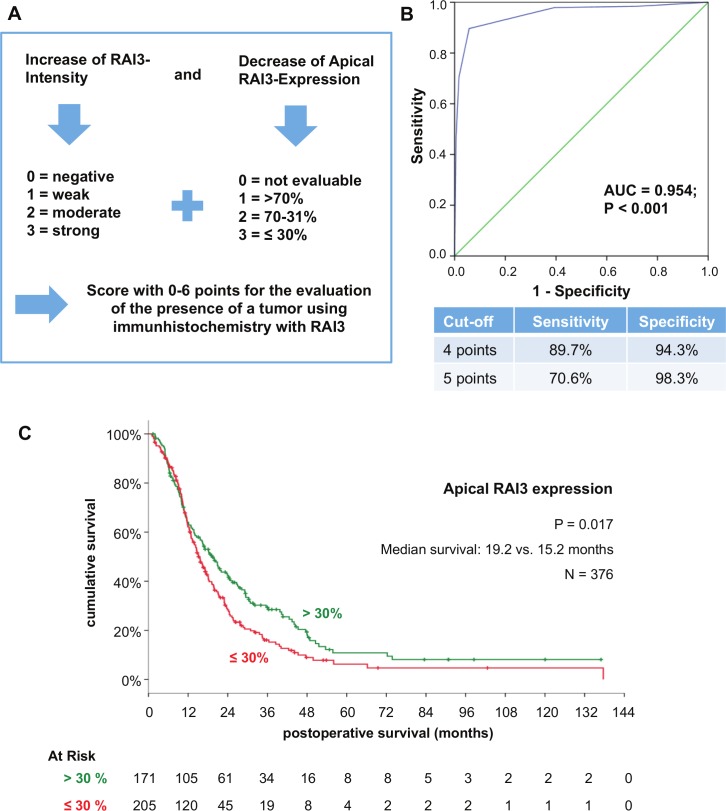
RAI3 immunohistochemistry as diagnostic and prognostic instrument.A: Definition and calculation of a diagnostic score for the presence of a pancreatic ductal adenocarcinoma (PDAC); B: Receiver Operating Characteristic (ROC) curve for the diagnostic score using for distinction of PDAC from Normal or Chronic Pancreatitis (CP) tissue (Sensitivity and specificity were calculated for two exemplary cut-off-points); C: Univariate Kaplan-Meier analysis (statistically significant differences between apical expression over 30% and less (p = 0.017) according to Log-Rank-test).